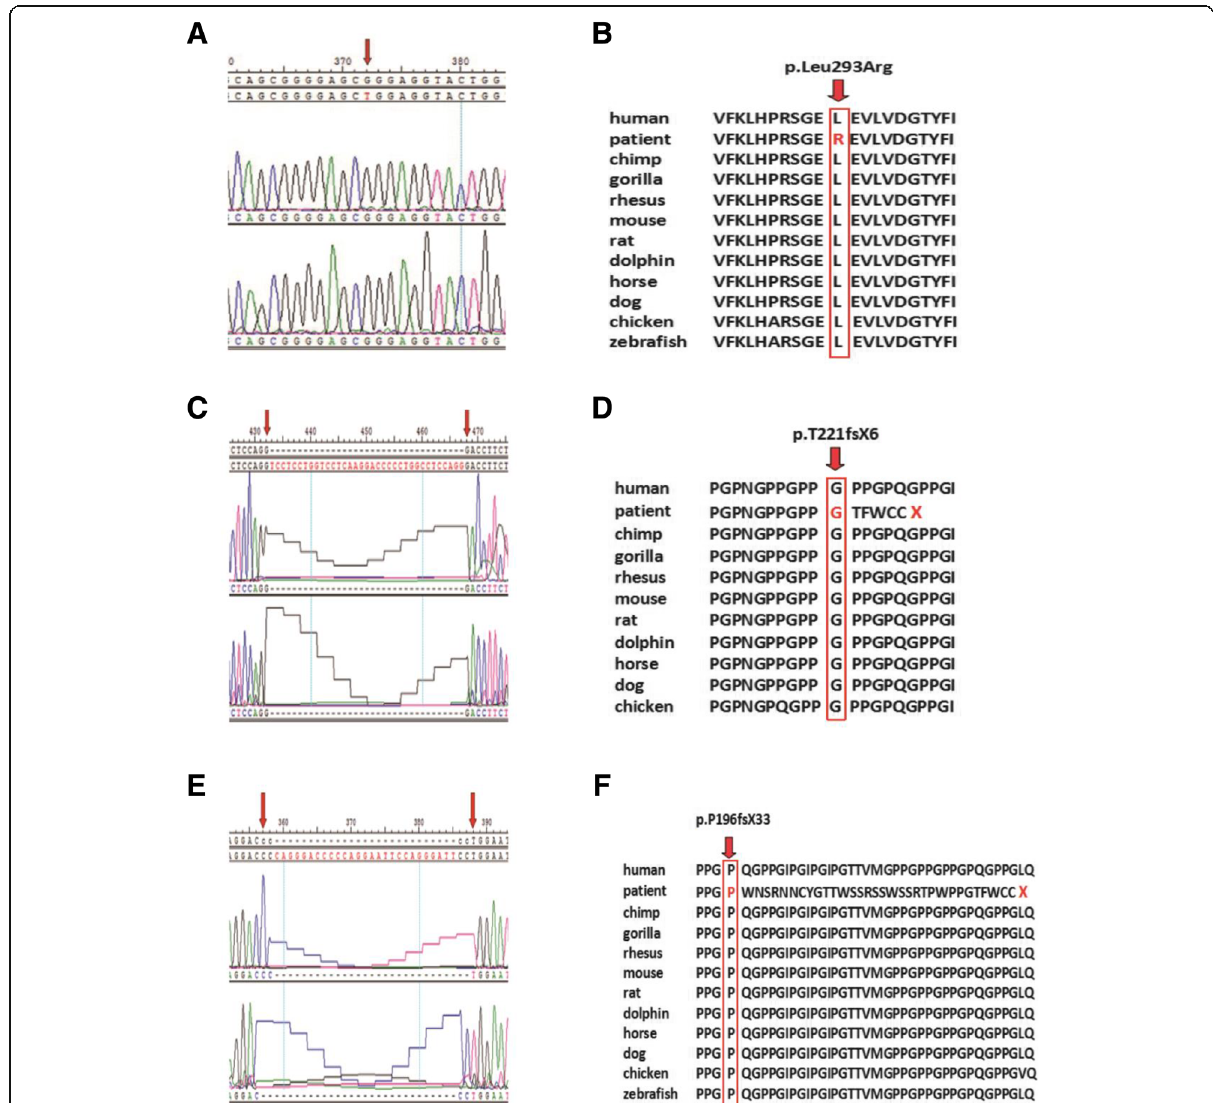
Fig. 3 Comparing the conservatism of three unknown EDA gene mutation sites among different species. ( a ) EDA gene mutation peak in the pedigree of c.878 T > G; ( b ) Conservation analysis of c.878 T > G mutation site among different species; ( c ) EDA gene mutation peak in the pedigree of c.663-697del; ( d ) Conservation analysis of c.663-697del mutation site among different species; ( e ) EDA gene mutation peak in the pedigree of c.587-615del; ( f ) Conservation analysis of c.587-615del mutation site among different species. These species included human, chimpanzee, gorilla, rhesus, mouse, rat, dolphin, horse, dog, chicken and